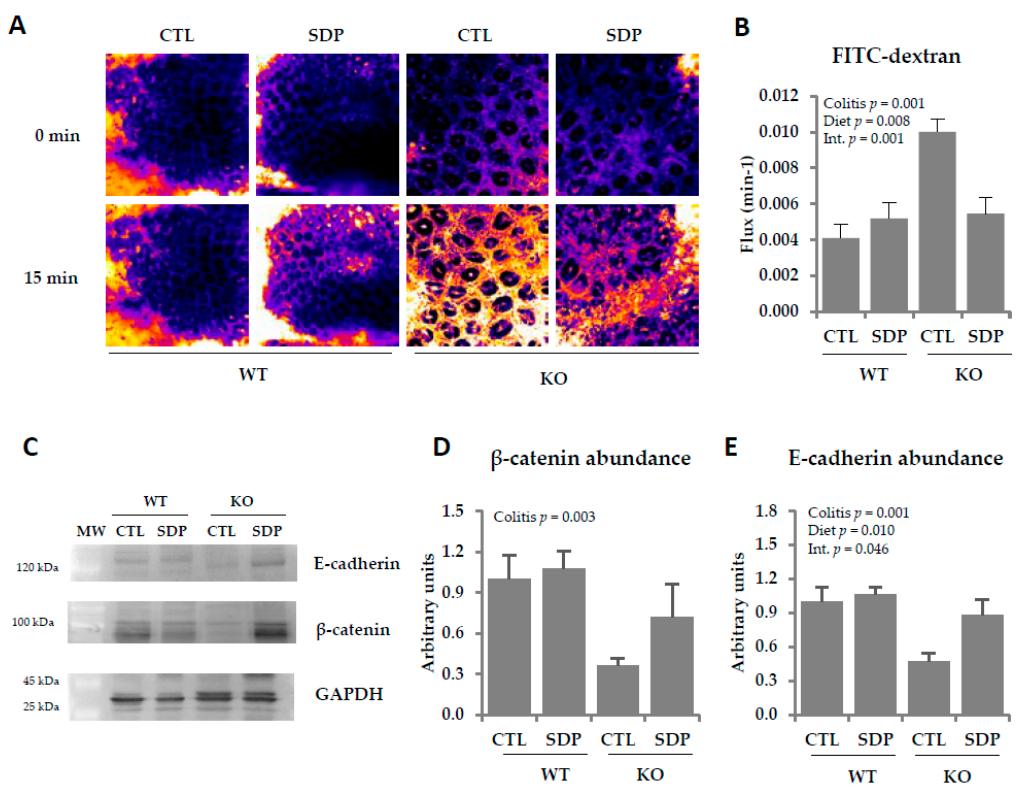
Figure 2. E ff ects of SDP supplementation on crypt permeability in the colonic mucosa of Mdr1a KO mice. ( A ) Representative images of FITC-dextran accumulation in the pericryptal sheath of the colonic mucosa after 15 min. All images were taken at the same magnification ( × 63). ( B ) Quantification of FITC-dextran accumulation in the pericryptal sheath of the colonic mucosa. ( C ) Representative Western blots of β -catenin (92 kDa), E-cadherin (132 kDa), and GAPDH (36 kDa). ( D ) β -catenin abundance in the colonic mucosa. ( E ) E-cadherin abundance in the colonic mucosa. Results are expressed as mean ± SEM ( n = 5–7 mice / group). CTL, control; Int., indicates the interaction between colitis and diet; MW, molecular weight; SDP, spray-dried porcine plasma. Table 1. E ff ects of SDP Supplementation on The Expression of Mucin 1 ( Muc1 ), Mucin 2 ( Muc2 ), Mucin 4 ( Muc4 ), Mucin 6 ( Muc6 ), and trefoil factor 3 ( T ff 3 ) in The Colonic Mucosa of Mdr1a knockout (KO) Mice. WT